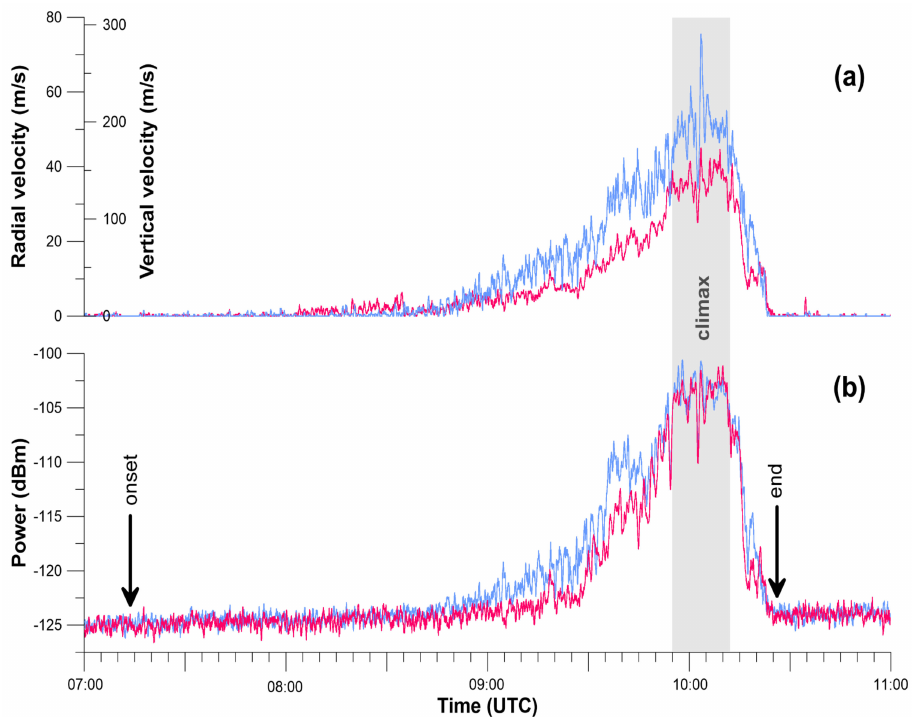
Figure 3. Radial and inferred vertical velocity ( a ) and echo power ( b ) measured by the VOLDORAD- 2B Doppler radar in the two beam volumes above New SE Crater (at 3135 m in red and 3285 m in blue) during the 23 November 2013 paroxysm of Etna. Displayed data represent only the spectral contributions associated with a positive Doppler shift corresponding to uprising tephra and used to compute the MER. Data were integrated over 1.1 s and averaged with a moving window of 21 data